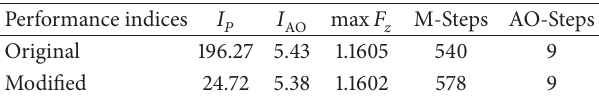
Table 2: Five performance indices from the 5% FP/min ramp load decrease simulation of the original and modified power control system in